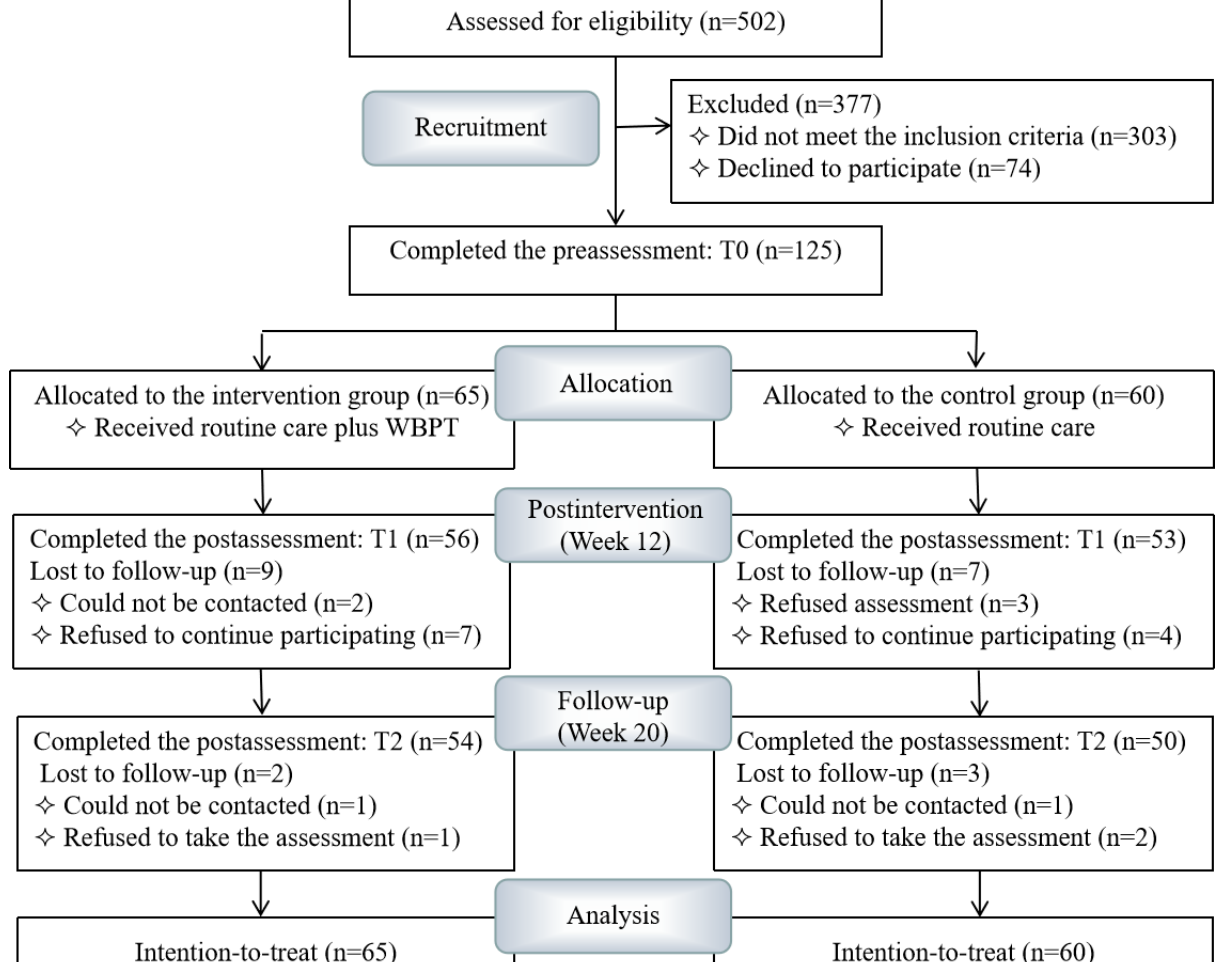
Figure 1. CONSORT flow chart of the study. CONSORT: Consolidated Standards of Reporting Trials; WBPT: WeChat-based parenting training.